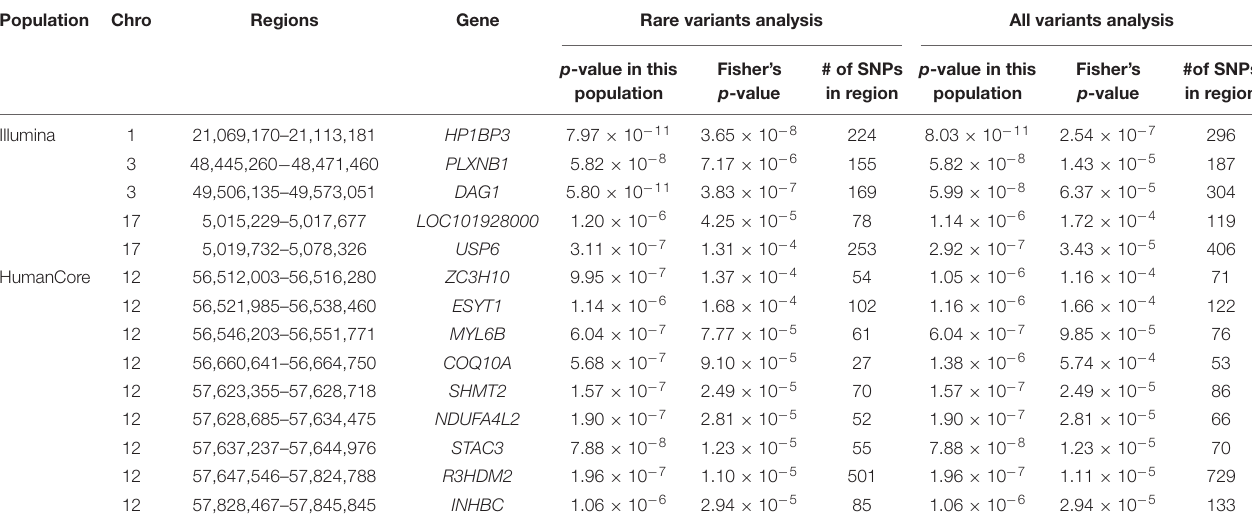
TABLE 5 | Regions identified by both rare and all variants analysis in a particular population after Bonferroni adjustment.